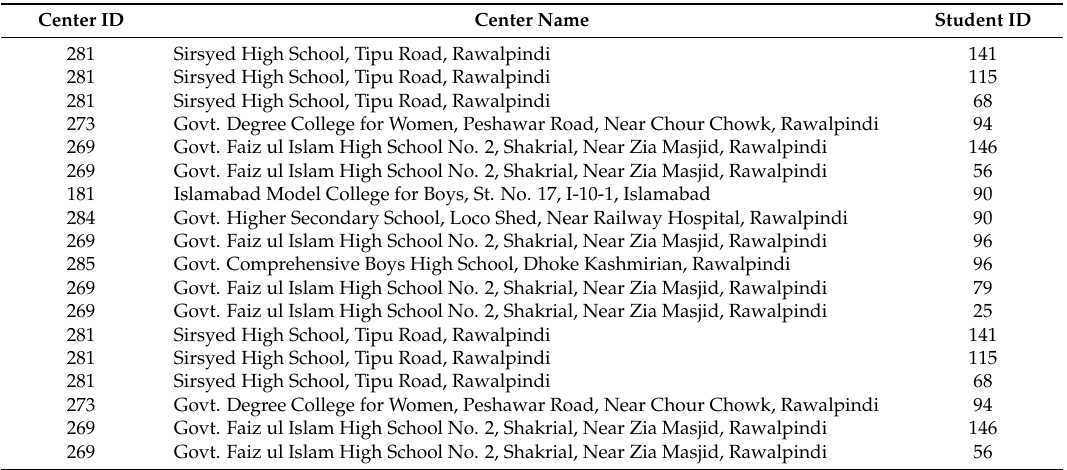
Table 1. Study centers allocated to